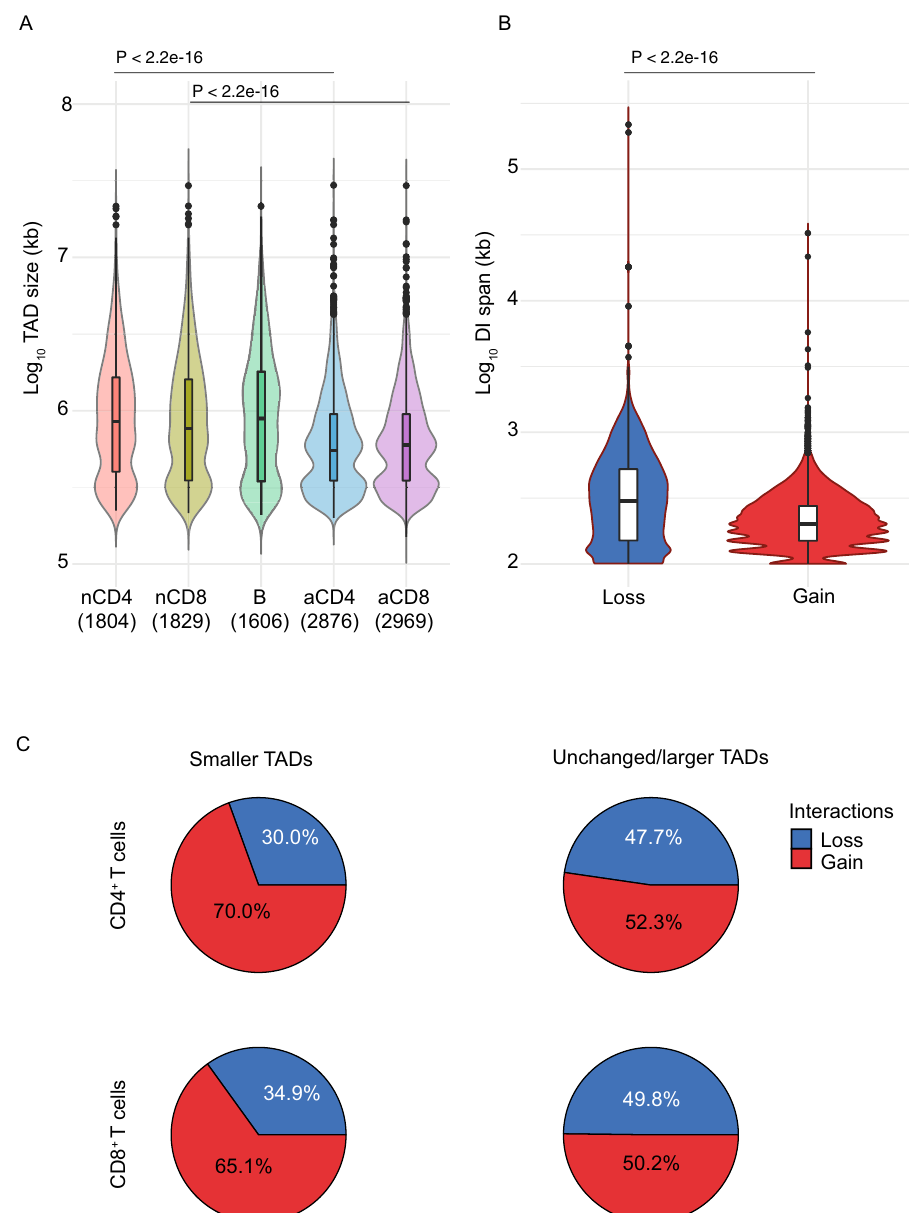
Figure 4. T cell activation results in partitioning of genome topology. ( A ) Violin plots showing the distribution of TAD sizes in resting and activated T cells and B cells determined from summed libraries called with TADbit. Numbers in parenthesis depict the number of TADs called in each category. ( B ) Violin plots showing the distribution of the span of differential chromatin interactions (DIs) determined at 25 kbp resolution (FDR < 0.05) that are lost (decrease in logFC) or gained (increase in logFC) upon activation. Violin plots show median (horizontal line), interquartile range (boxes), values of the upper and lower quartiles (whiskers), outliers (circles) and kernel density estimation. Data for CD4 + and CD8 + T cells were merged as they showed a similar pattern. ( C ) Pie charts showing distribution of Loss and Gain chromatin interactions in TADs that become smaller in size (left) or remain unchanged/became larger in size (right) upon T cell activation. Statistical comparisons were made with the unpaired Wilcoxon